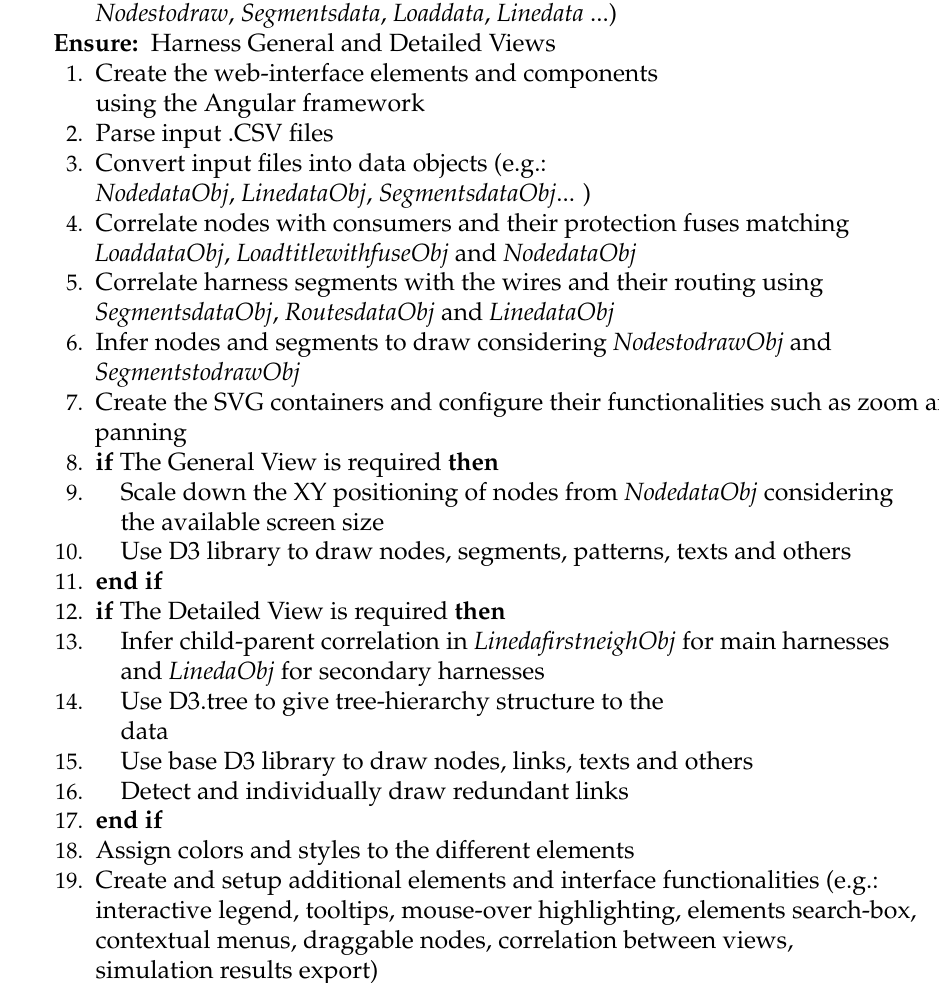
Algorithm 1: General and Detailed Views